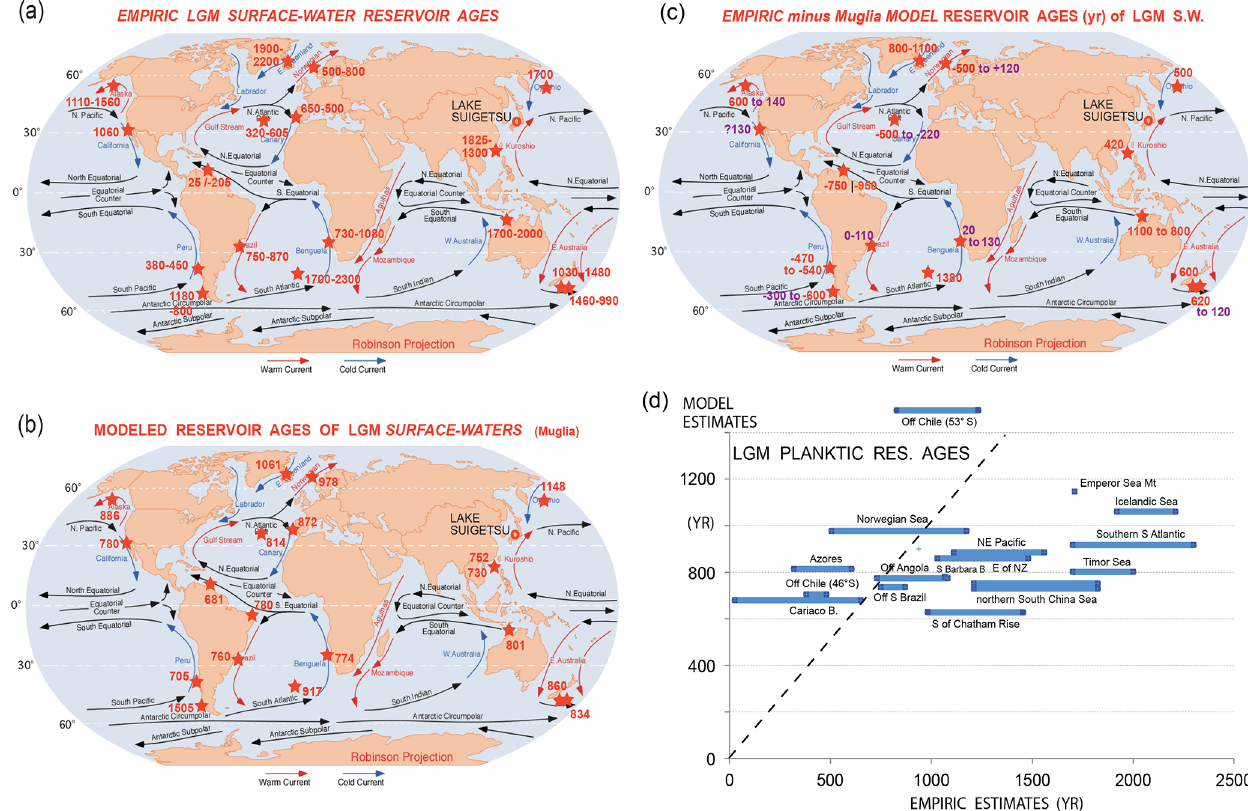
Figure 8. Global distribution of 14 C reservoir ages of Late LGM surface waters estimated (a) by means of 14 C plateau tuning of planktic 14 C records. (b) Model-based estimates (GCM of Muglia et al., 2018, assuming an Atlantic Meridional Overturning Circulation, AMOC, strength of 13Sv) for sites with planktic foraminifera-based age values. The x – y graph (d) and map (c) show (rounded) differences between observed and modeled values and their intra-LGM trends. Minor differences are displayed in magenta, and larger differences of > 400 years are shown in red. Planktic habitat depths and model estimates are largely confined to 0–100m water depth. Arrows of surface currents delineate different sea regions important to assess potential limits of spatial extrapolation of reservoir ages. Distribution of core numbers and references for 14 C records are given in Table 3 and Fig.